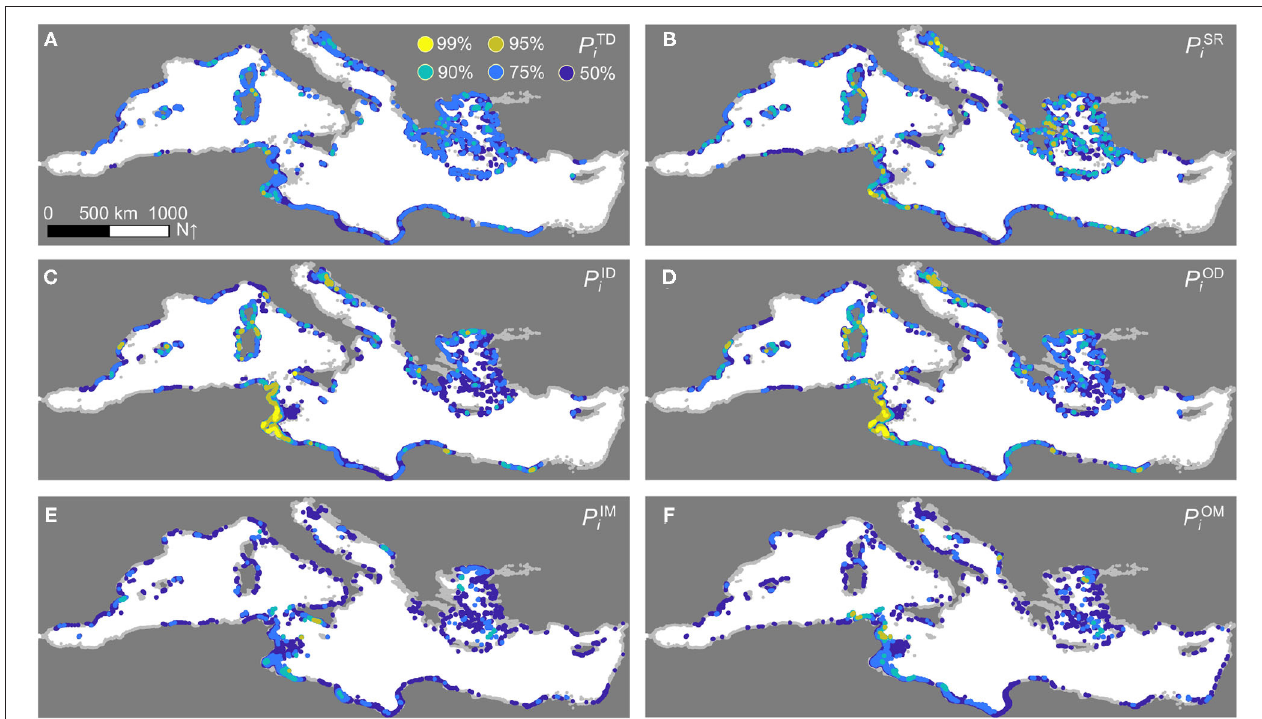
FIGURE 5 | Hotspots of P. oceanica metapopulation dynamics. (A) Abundance hotspots. (B) Self-retention hotspots. (C) Indegree hotspots. (D) Outdegree hotspots. (E) Inbound displacement hotspots. (F) Outbound displacement hotspots. Colors identify sectors that, for a given metric Q ∈ { TD,SR,ID,OD,IM,OM } , are above the k -th percentile of the P Q i across-sector distribution ( k ∈ { 50,75,90,95,99 } ). The higher is the percentile, the hotter is the spot. Sectors for which P Q i < 50 % are shown in light gray. Results refer to the simulation of Figure 2